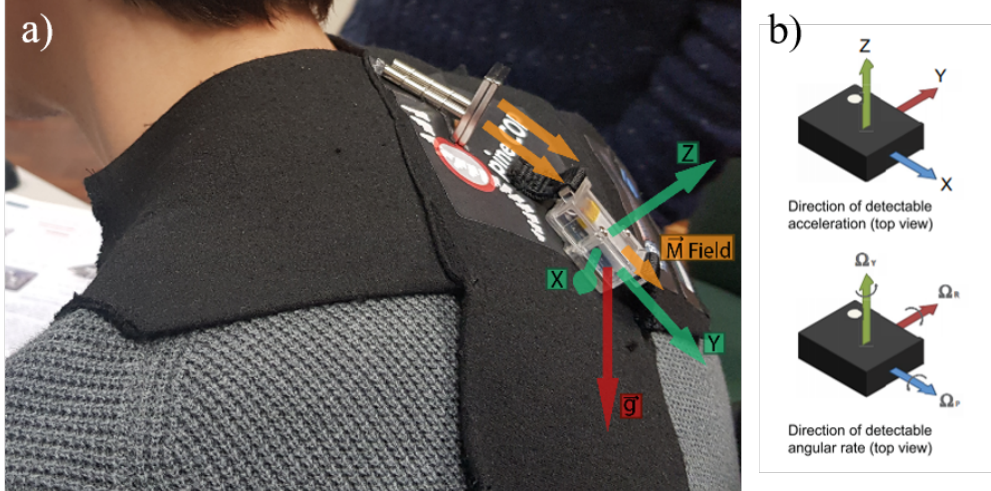
Figure 2. ( a ) Magnetic field and accelerometer orientations of the SensorTile device on the wearer’s back. ( b ) Accelerometer and gyroscope orientations on the SensorTile device (LSM6DSM